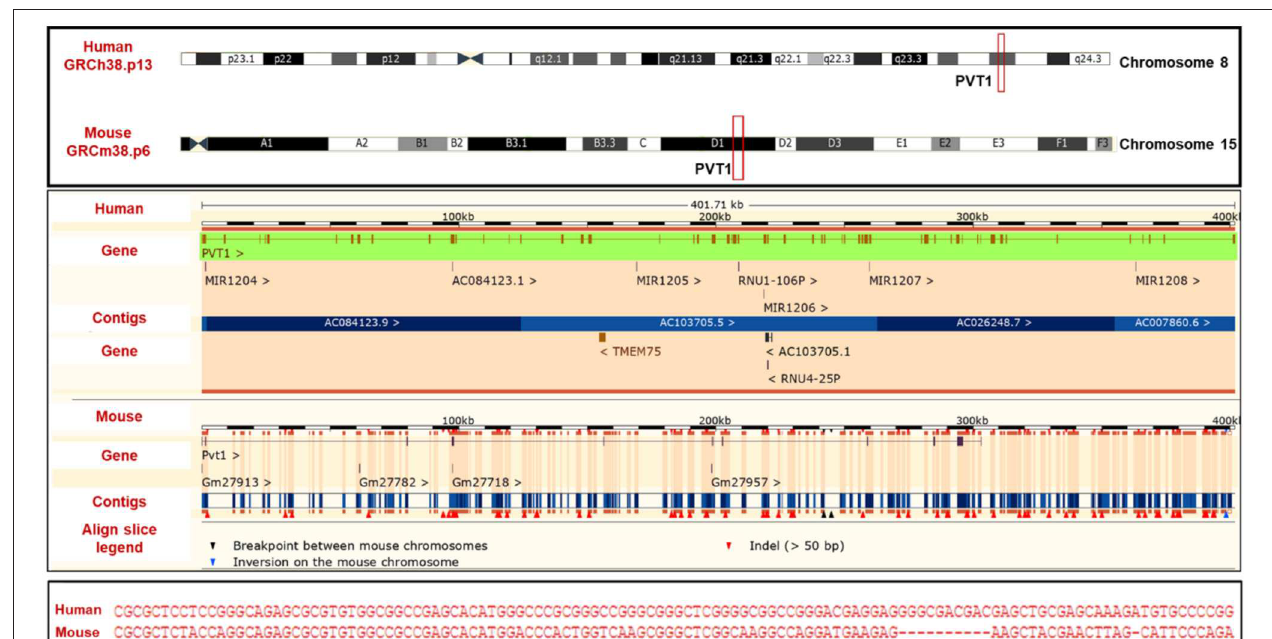
FIGURE 1 | PVT1 (Top) PVT1 gene locus (Middle) alignment of human PVT1 and mouse pvt1 (Bottom) Sequence homology of human PVT1 and mouse pvt1. Figure was created using information from Ensembl genome browser.